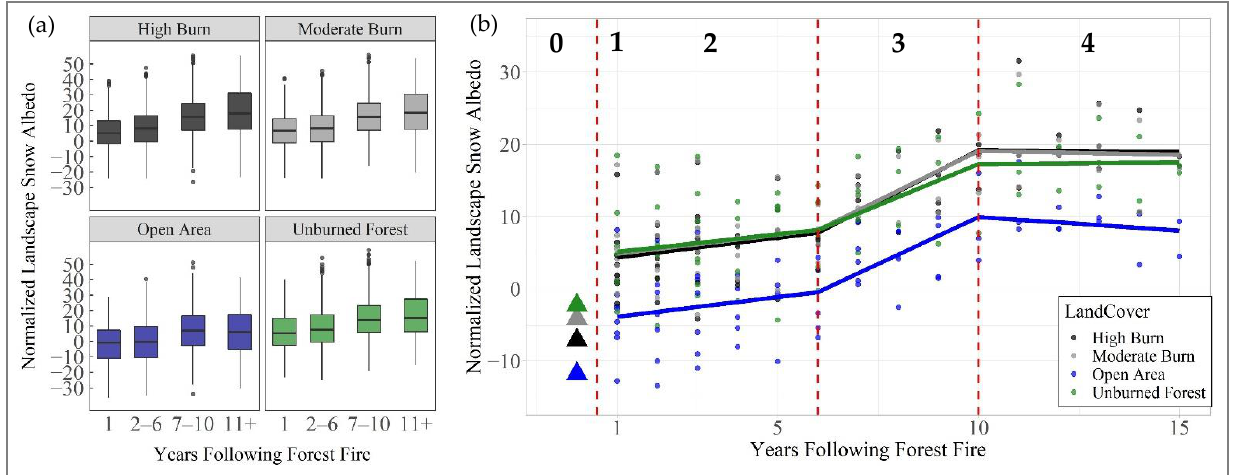
Figure 4. ( a ) Post-fire snow albedo change normalized to the buffer area. Normalized landscape snow albedo results in post-fire snow albedo change in the four stages of recovery. High burn (black), moderate burn (gray), and unburned forest (green) were normalized according to the buffer forest area. The open area (blue) was normalized according to the buffer open area. ( b ) Spline regression relative to burn severity. Linear spline regression representation with (0) pre-fire averages (triangles), (1) immediate brightening (0–1 years post-fire), (2) initial stage of tree mortality (1–6 years post-fire), (3) intermediate recovery (6–10 years), (4) long term recovery (10+ years) relative to high burn (black), moderate burn (gray), unburned forest (green), open area (blue) land classifications. Table 3. Post-fire comparisons of percent LSA increase relative to burn severity classification, and pre- vs. post-fire comparisons of percent LSA increase relative to burn severity. Results from the daily normalized LSA Tukey Honestly Significant Difference test based on the piecewise compar- isons of burn severity classification in post-fire comparisons and pre- vs. post-fire comparisons. *** = p -value <